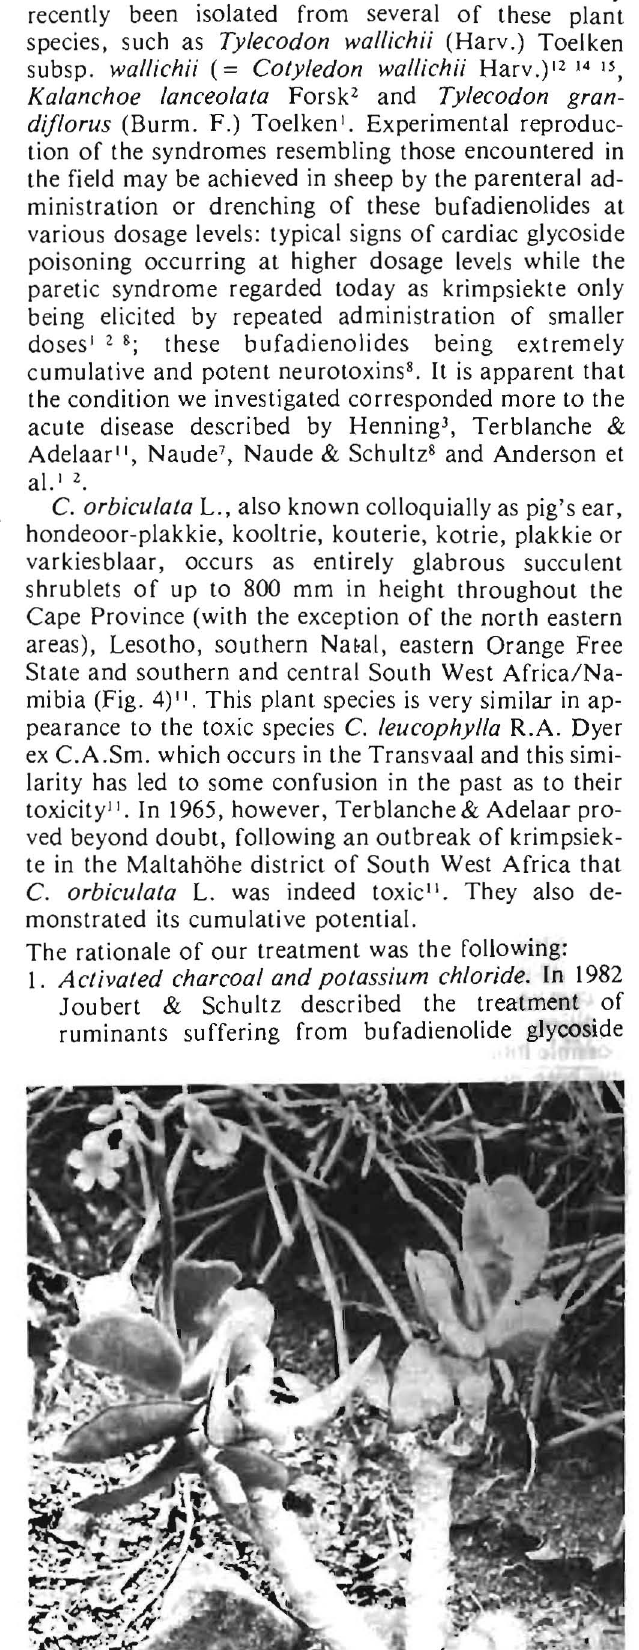
Fig. 4: Cotyledon orbiculata